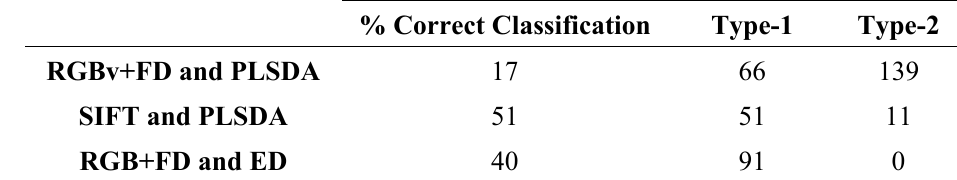
Table 2. Percentages of correct classification and number of different Type 1- and Type 2- Errors (see Section 2.3. for acronyms explications) obtained with the three different processing methods for the automated counting of squat lobsters ( Munida quadrispina ) at VENUS cabled observatory (see Figure 1). RGB, Red-Green-Blue colour channels; RGBv, Mean RGB; FD, Fourier Descriptors, PLSDA, Partial Least Square Discriminant Analysis; ED, Euclidean Distance; SIFT, Scale-Invariant Feature